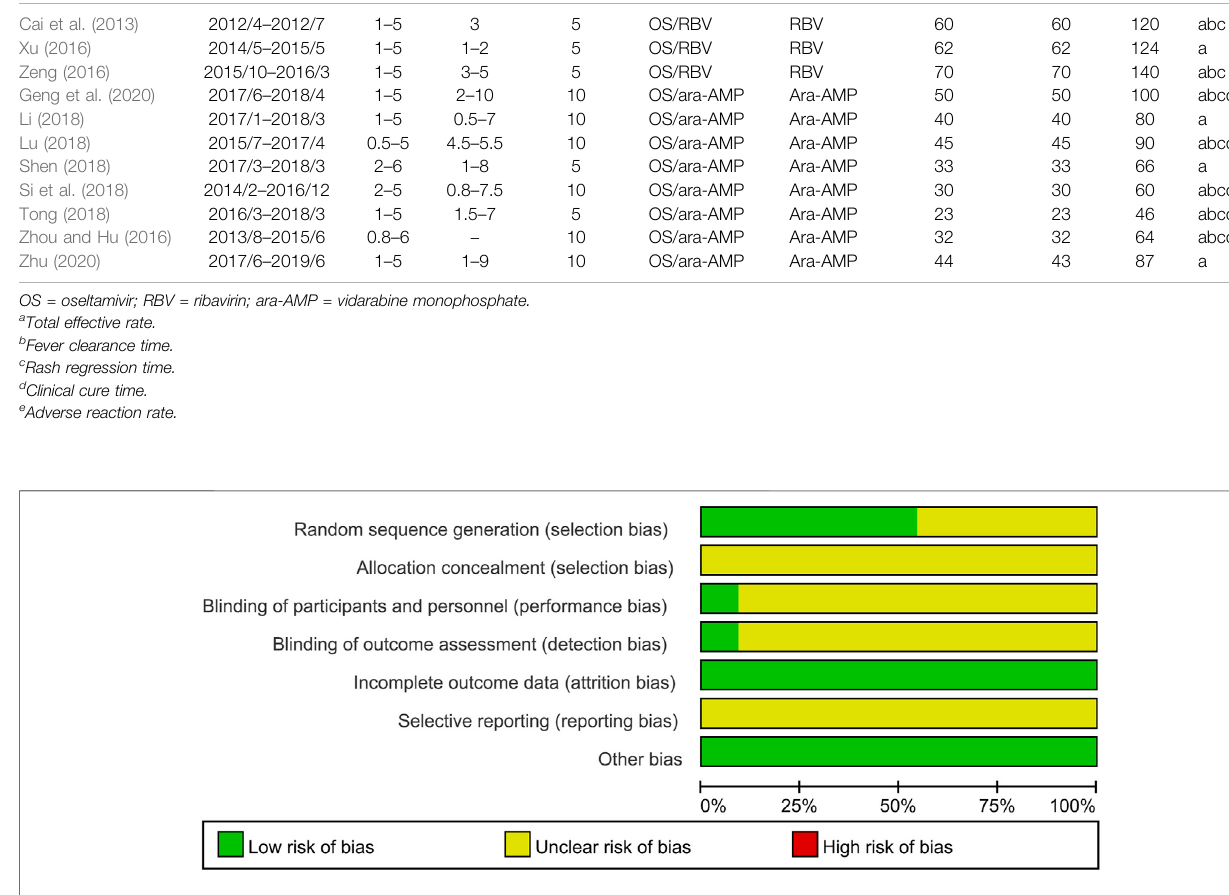
FIGURE 2 | Risk of bias assessment for studies included using the Cochrane Collaboration ’ s